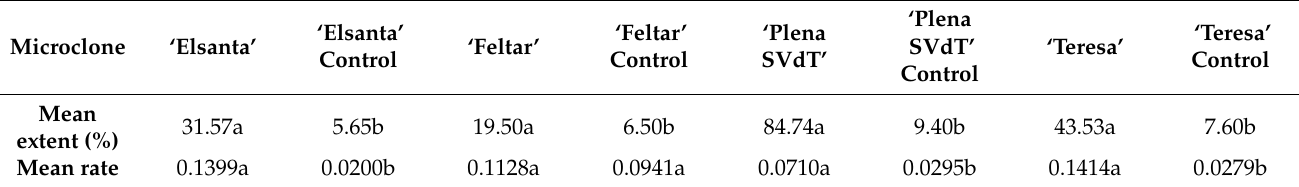
Table 4. Differences between the mean extent (%) and mean rate of Phytophthora disease, and the control sample in the studied microclones. Means marked with the same letter do not differ significantly at p ≤ 0.05.